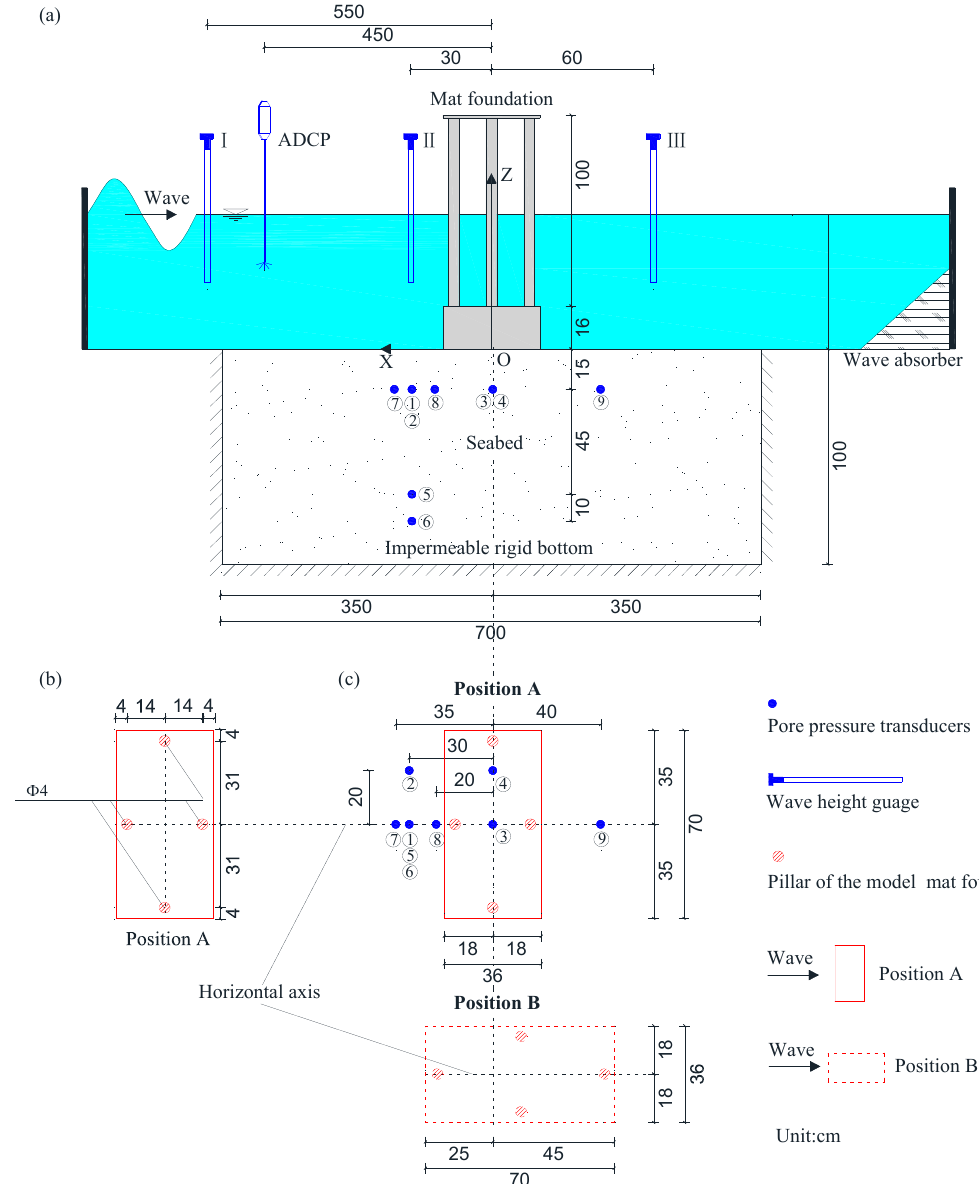
Figure 2. Sketch of experimental set-up: ( a ) An overview, ( b ) dimension of the pillars and ( c ) set-up the transducers around mat foundation (unit: of the transducers around mat foundation (unit: cm).